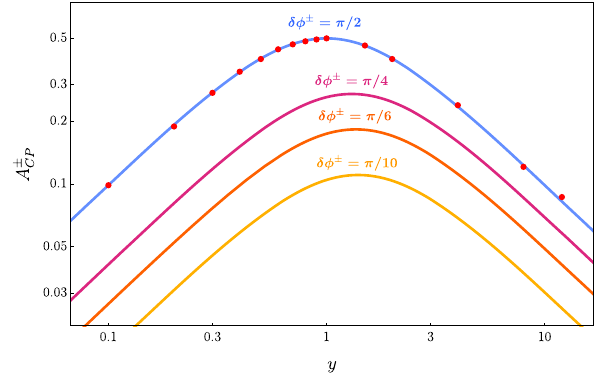
Fig. 6 CP violating ratio A ± , defined in Eq. (37), as function of the CP relevant ratio y = (cid:14) M N /(cid:9) N and for different choices of the relative phases δφ ± . Red dots were obtained with Whizard as a cross-check of our analytical results